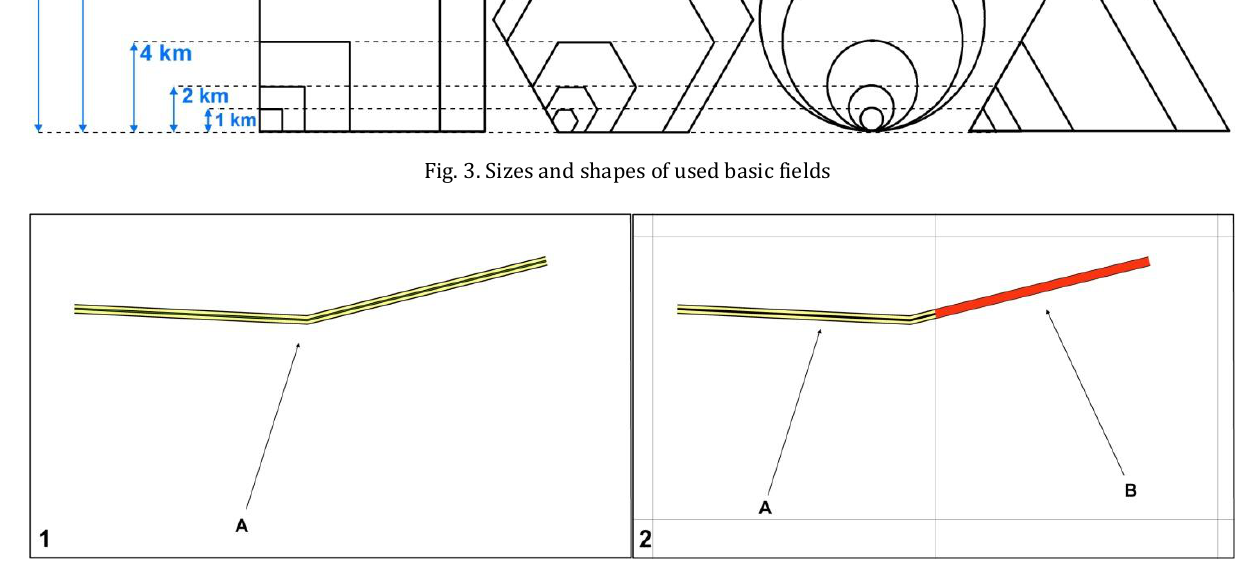
Fig. 4. Line data before (1) and after intersection (2) by the square basic fields